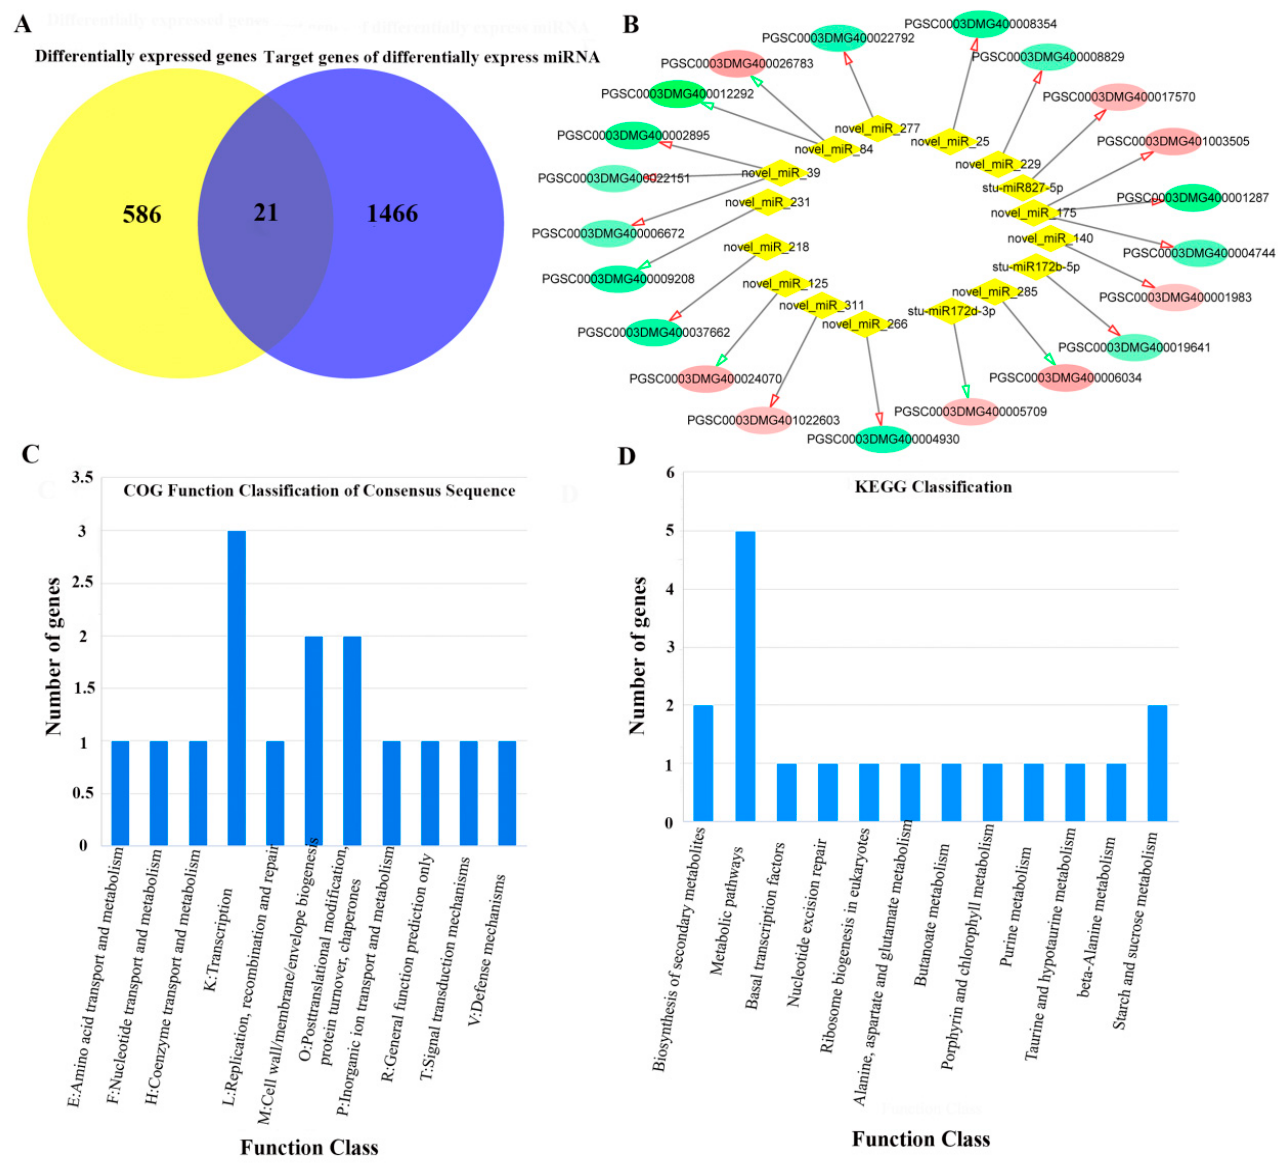
Figure 5. Regulatory network from the integrated analysis of miRNA-mRNA data. ( A ) The intersection between DEGs and target genes of DEMs. ( B ) The regulatory network between DEGs and target genes of DEMs. Note: The red circle represents upregulated DEGs and the green circle represents downregulated DEGs. Red arrow indicates upregulated miRNA, green arrow indicates downregulated miRNA. ( C ) COG function classification based on the intersection between DEGs and target genes of DEMs. ( D ) KEGG function classification based on the intersection between DEGs and target genes of DEMs.